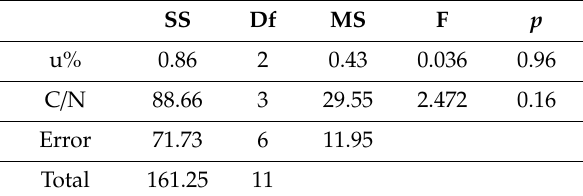
Table 10. ANOVA for fluorescein production.